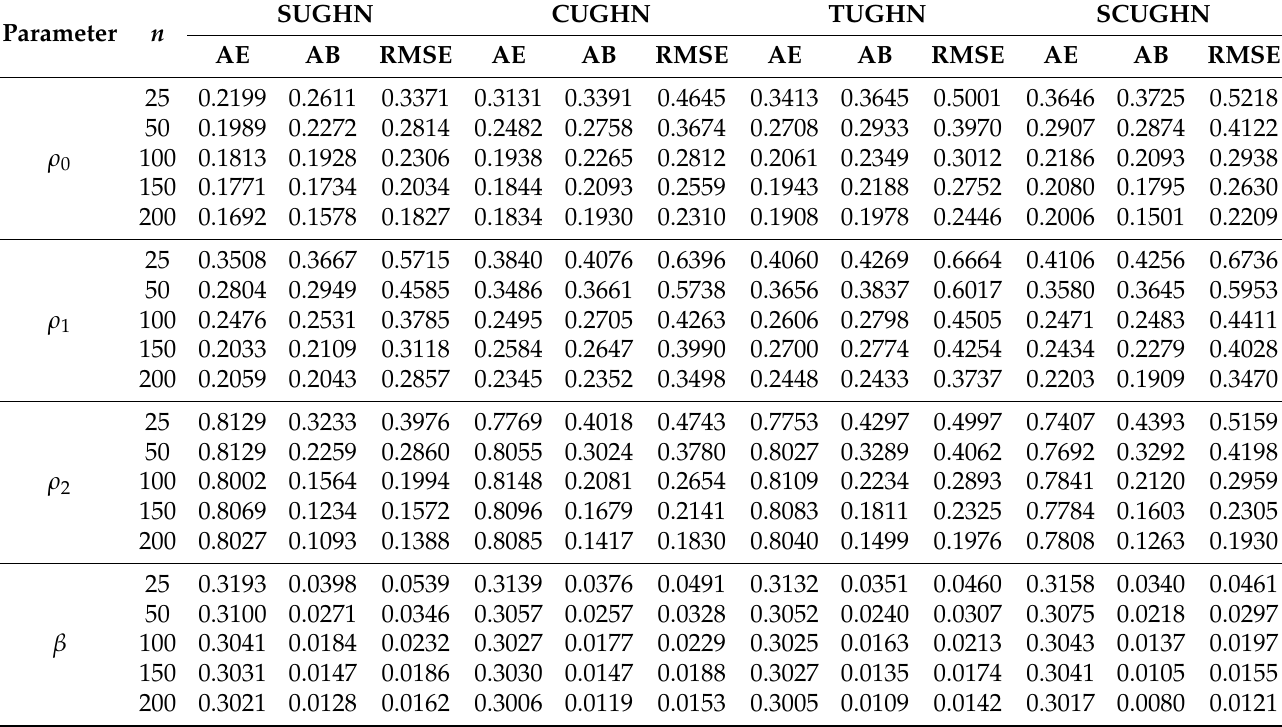
Table 1. Simulations results for ( ρ 0 , ρ 1 , ρ 2 , β ) = ( 0.2,0.1,0.8,0.3 ) .